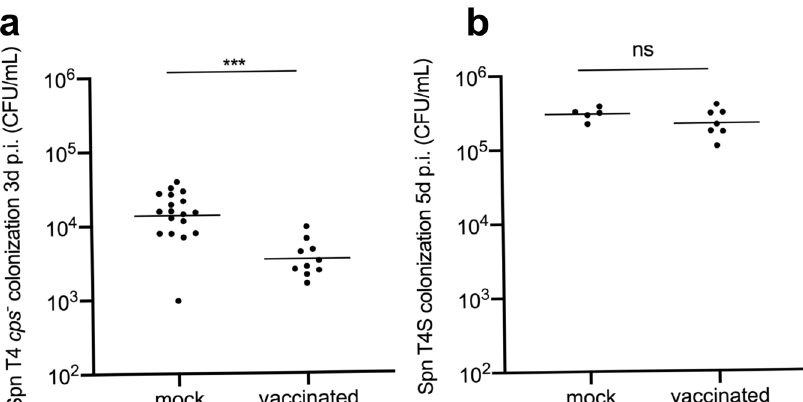
Fig. 4 Effect of immunization on infant mouse colonization. Dams were vaccinated with the fi ve-antigen combination (StkP, PenA, PgdA, HtrA, and LytD) with adjuvant and compared to adjuvant alone controls (mock). After the immune response was con fi rmed, they were bred and pups were challenged with the a unencapsulated mutant (T4 cps- ) or b its encapsulated parent strain (T4S). Symbols represent colonization density (CFU/ml upper respiratory track lavage) for individual mice at 3 (T4 cps -) or 5 (T4S) days post-infection with median values shown. Mann – Whitney test used for comparisons. *** P < 0.001, n.s., non-signi fi